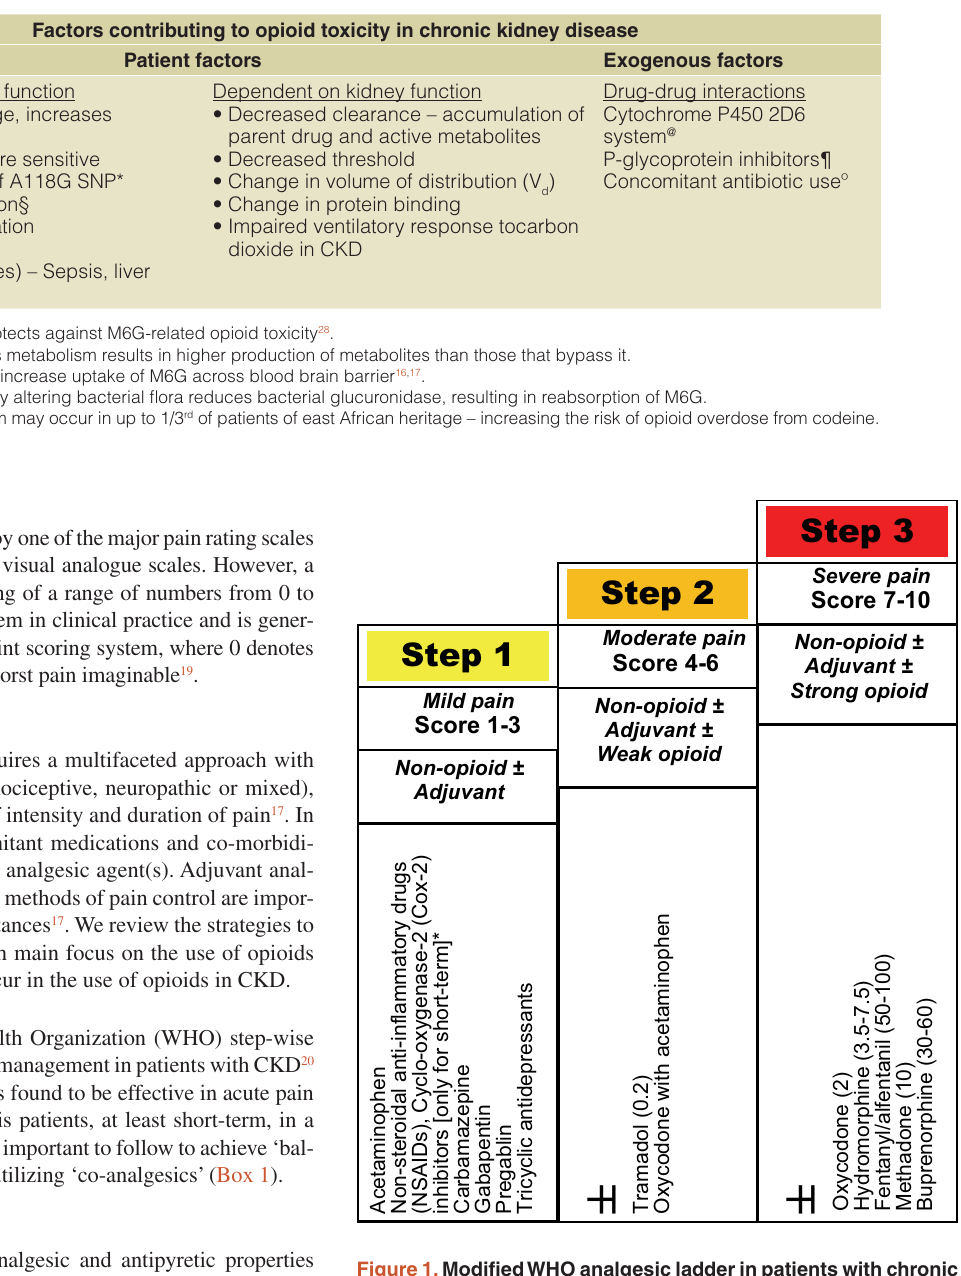
Table 1. Factors contributing to opioid toxicity in